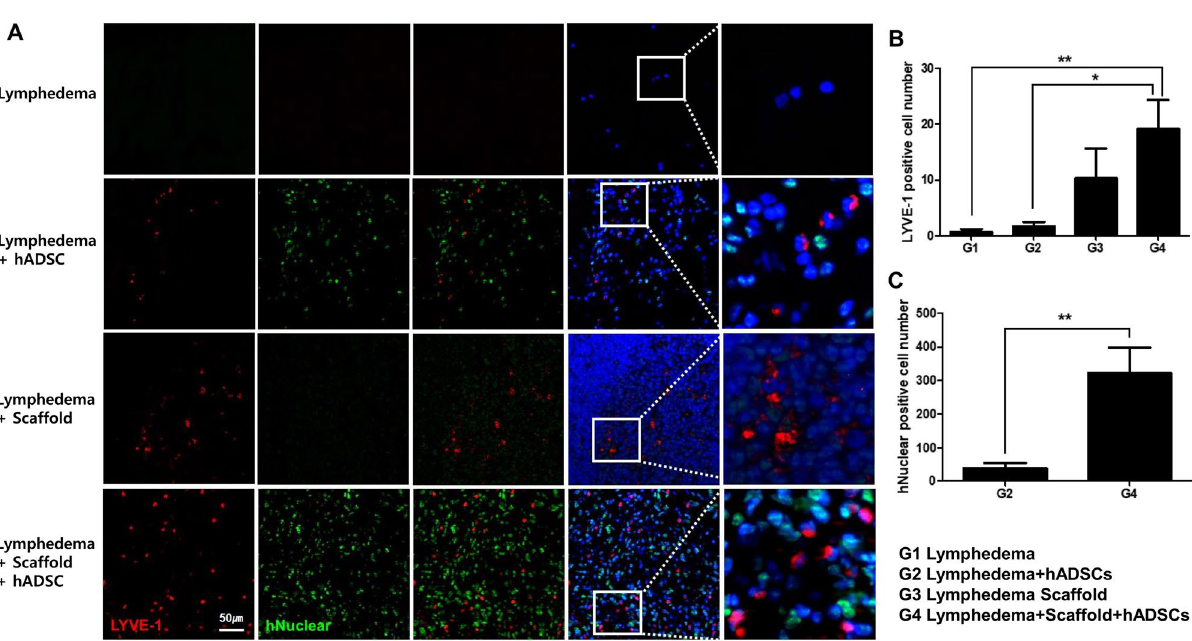
Figure 5. LYVE-1 and human nuclear expressions were assessed by immunofluorescence staining. ( A ) LYVE-1 and hNuclear were not expressed in lymphedema group, and the expression of LYVE-1 was hardly expressed and some positive cells of hNuclear was confirmed in ADSCs treatment group. LYVE-1 was slightly expressed and hNuclear were not expressed in the Decell LN-scaffold group. In the Recell LN-scaffold group, most of the cells were hNuclear positive, and LYVE-1 expression was observed in some of the hNuclear positive cells. ( B,C ) Bar graphs showing that rat in the Recell LN-scaffold group had the greatest number of LYVE-1 and hNuclear- positive cells (* P < 0.05, ** P < 0.01). LYVE-1 lymphatic vessel endothelial hyaluronan receptor 1, hNuclear human